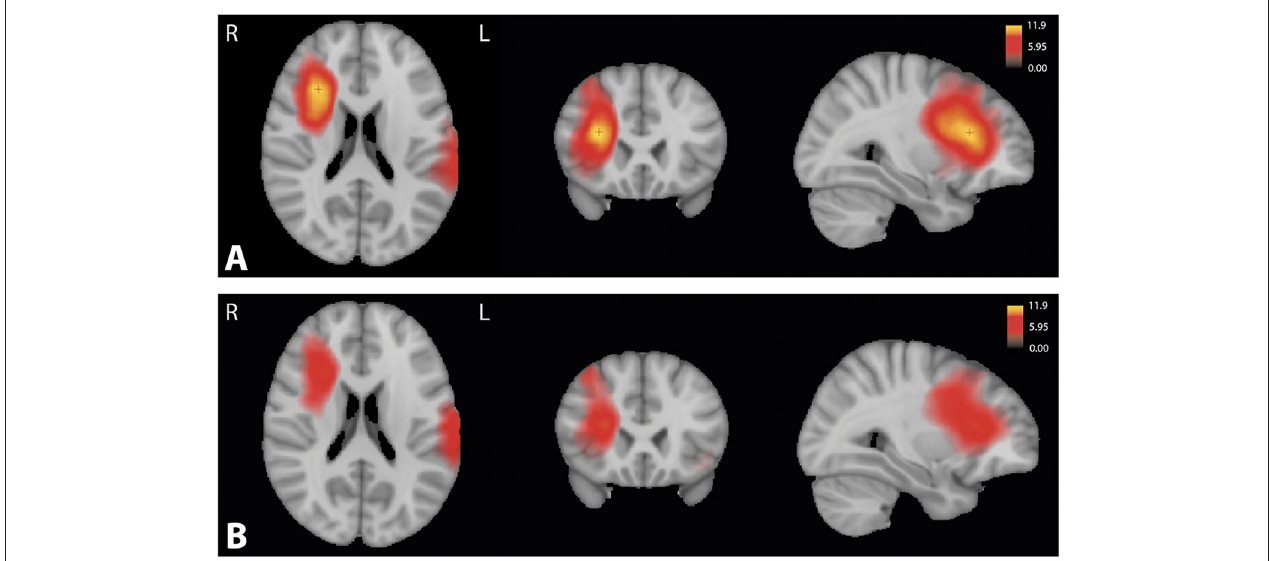
FIGURE 9 | Significant T -value map ( p < 0.05) computed using ANOVA corrected by the family-wise error method between the attention maps of the control group and (A) the amnestic and (B) the non-amnestic groups. Coordinate of the slice (25.11, 18.40, 25.92). R, right hemisphere; L, left hemisphere; ANOVA, Analysis of variance.